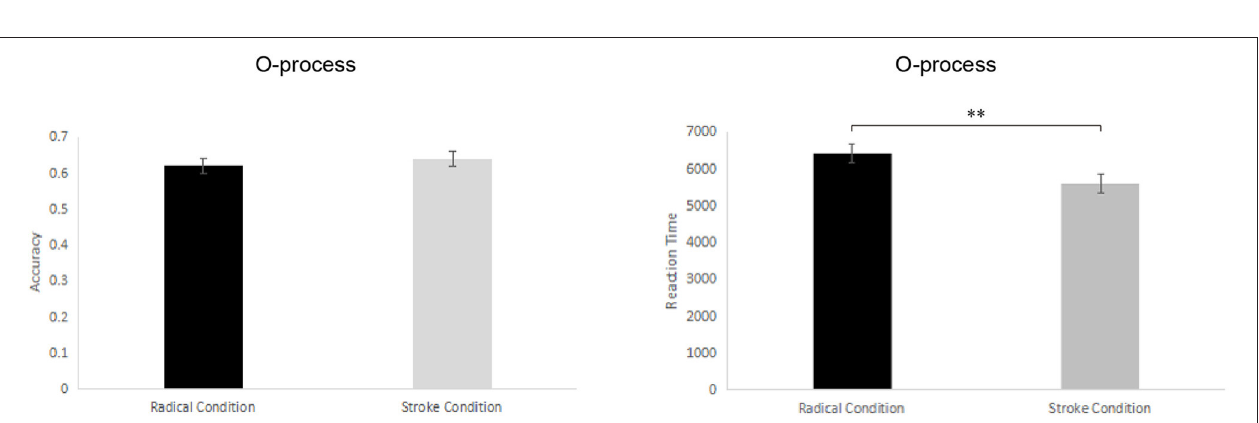
FIGURE 4 | Comparisons of the accuracy and reaction time between the stroke level and the radical level of the O-process tasks. The error bars (capper vertical bars) represent the standard errors. ** Indicates a significant difference at p <